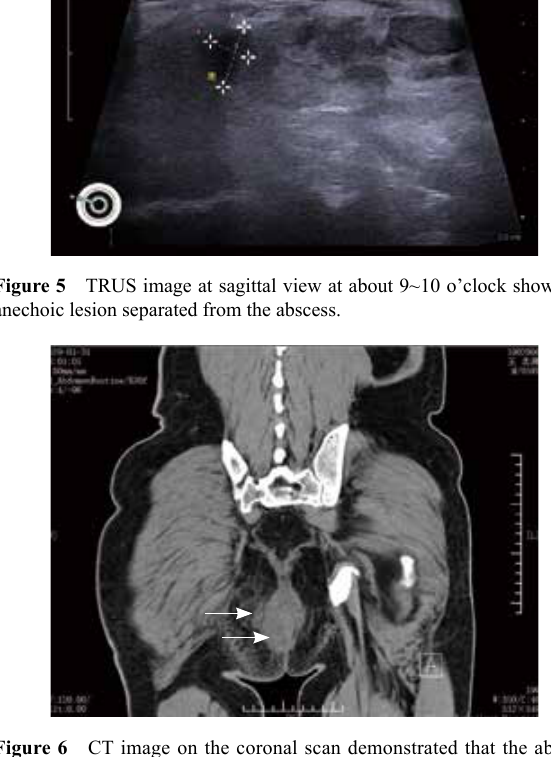
Figure 6 CT image on the coronal scan demonstrated that the abscess (arrows) in the intersphincteric space extended and crossed the external sphincter into the ischiorectal